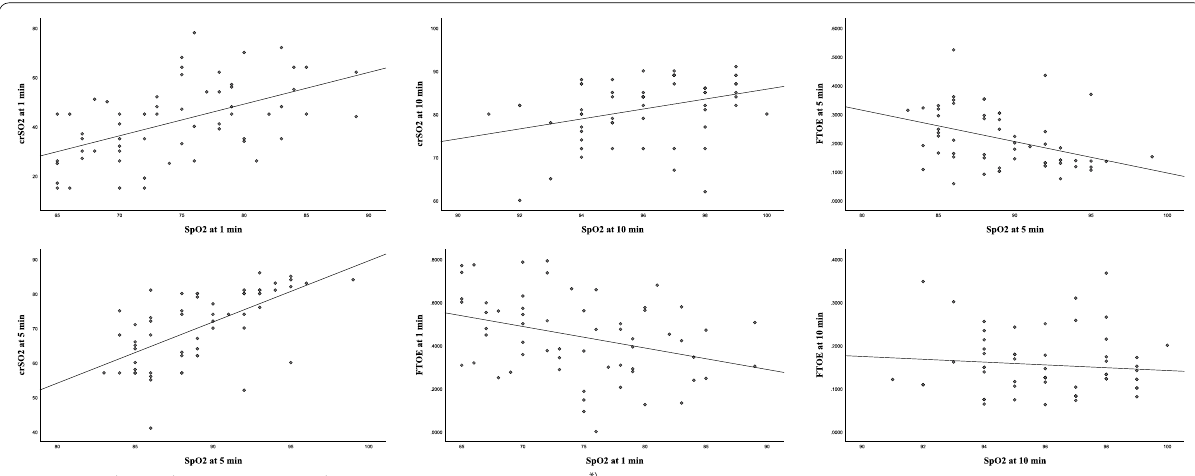
Fig. 2 Correlations between SPO2, and 1 min crSO2 ( r 1 min FTOE ( r